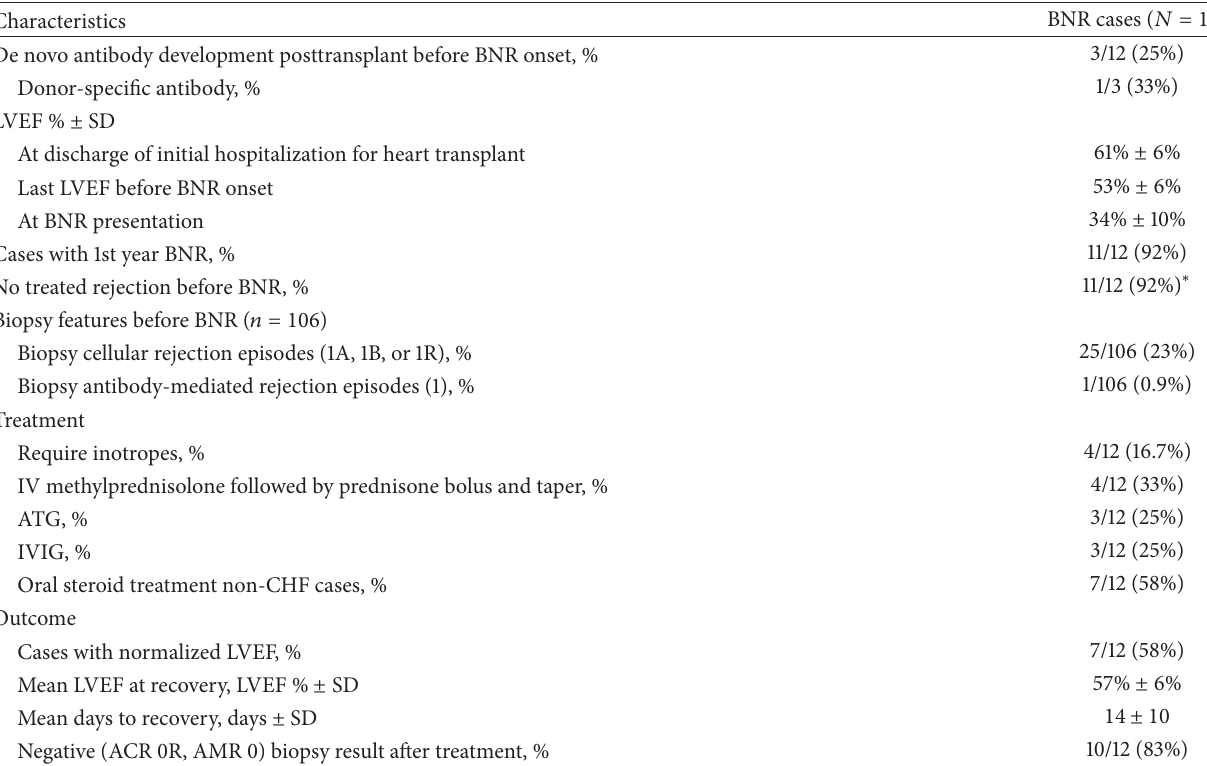
Table 3: Characteristics of biopsy-negative